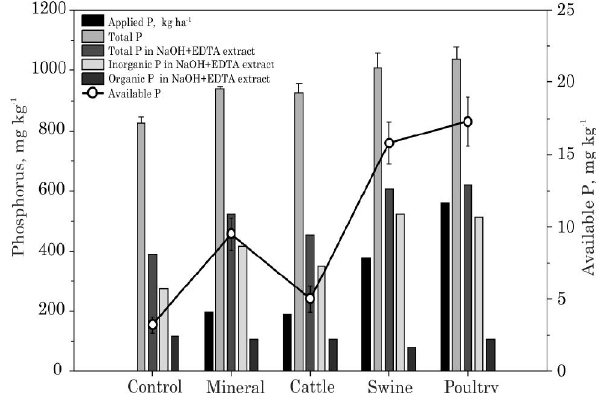
Figure 2. Amount of phosphorus added by fertilizers, total and available P by chemical methods and orthophosphate P and inorganic P by 31 P-NMR analysis in soil after nine years of cultivation under no tillage with application of mineral fertilizer and different kinds of organic fertilizers. Error bars represent the standard error of analytical